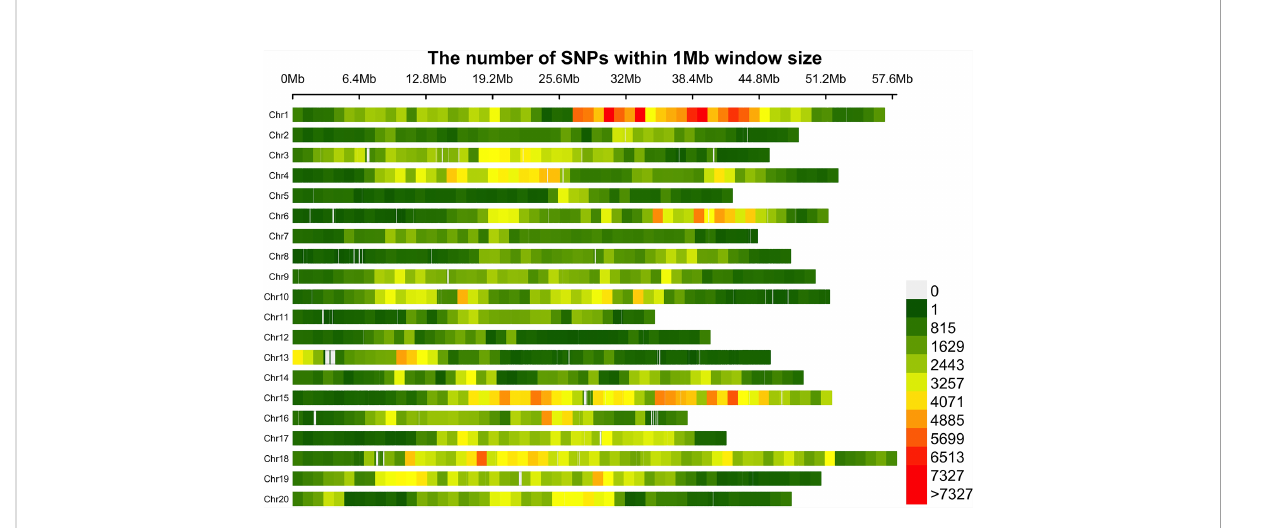
Figure 6 Of these, three sites (Gm_09_28400545, Gm_11_31100989, Gm_19_557643) could be found in all